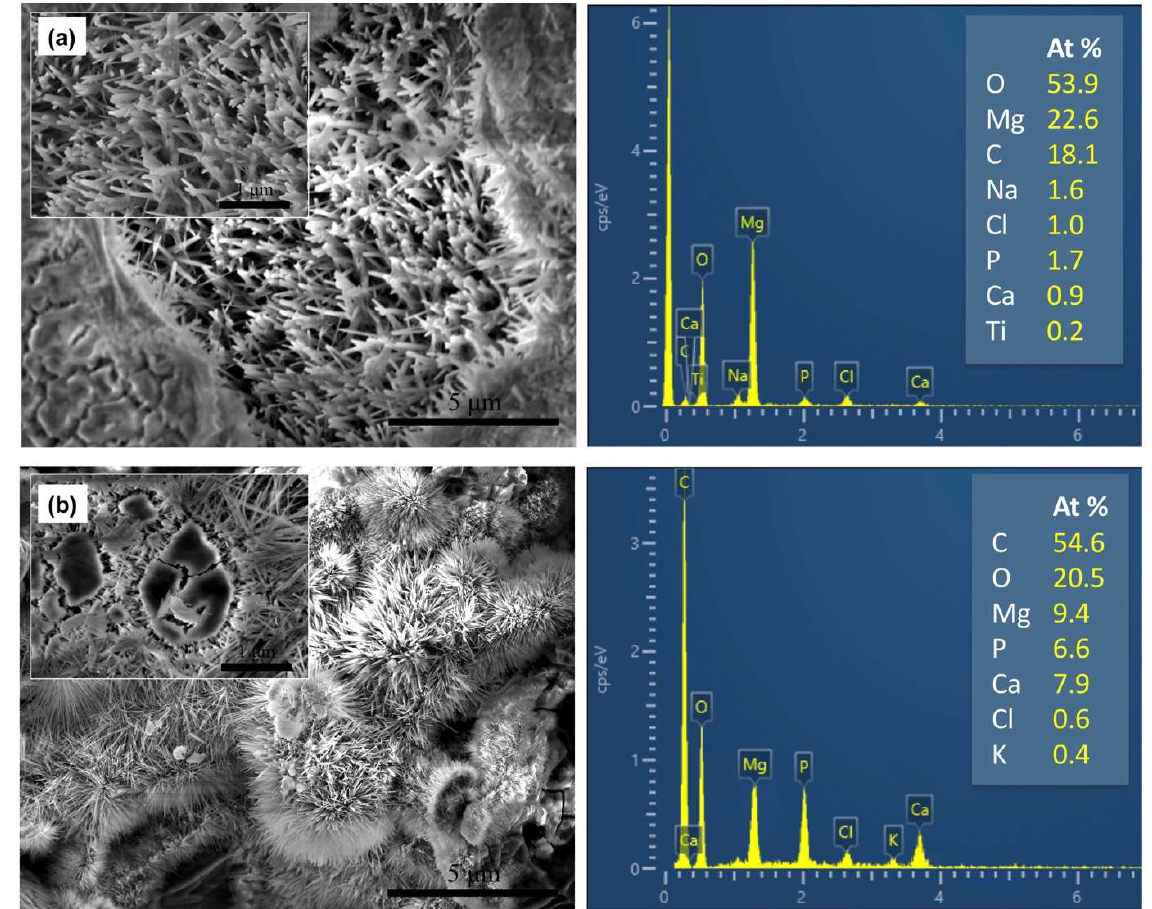
Figure 8. SEM-EDX characterization of TNC-coated ZM21 after ( a ) 14 days and ( b ) 28 days of SBF immersion.